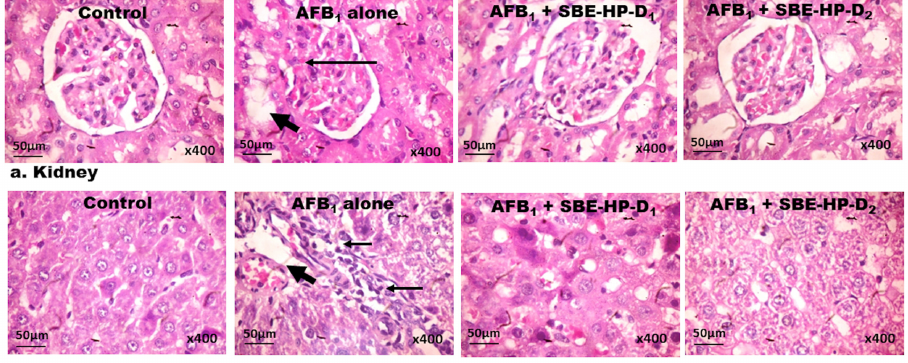
(thin arrow) and the extent of infiltration of the cortex by inflammatory cells (bold arrowhead). SBE- HP alone plate (not shown) tissues appear normal and relatively like those from control tissue